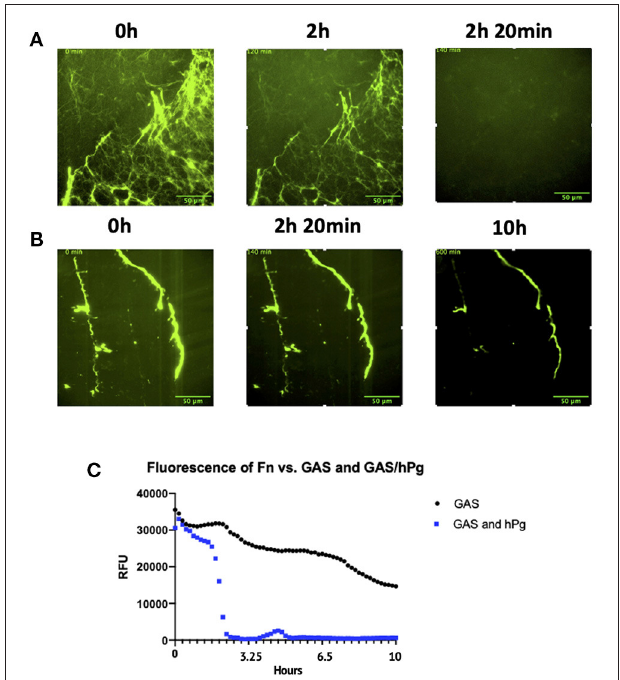
FIGURE 8 | Activation of hPg by AP53R + S − causes Fn clot lysis. Prior to live imaging, the Fn clot was incubated with: (A) AP53R + S − at an MOI of 5 along with 7 µ g/mL of hPg or with (B) only AP53R + S − at an MOI of 5. (C) Fluorescence measurements reveal the dissolution or maintenance of the Fn over a 10h period. The images were obtained every 10min for 10h for the duration of the imaging experiment. Time-lapsed images of experiment are shown here (see Supplementary Videos 5, 6